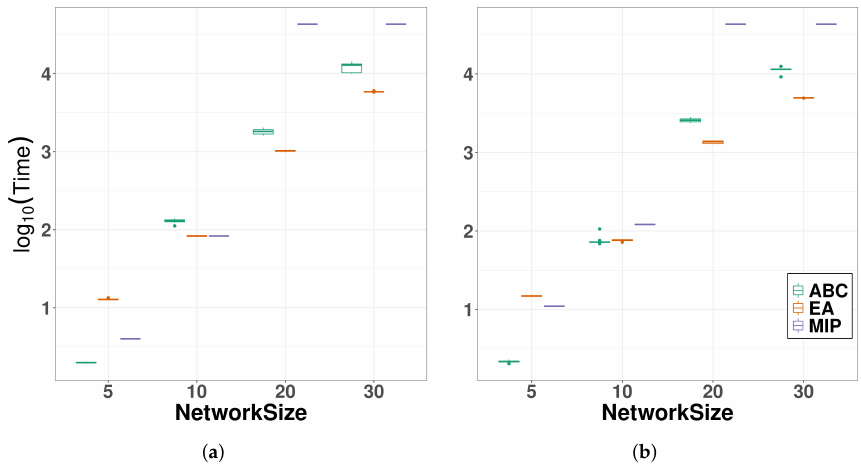
Figure 3. Box plot of calculation time for heuristic methods for the BLP—( a ) and ELP models—( b )